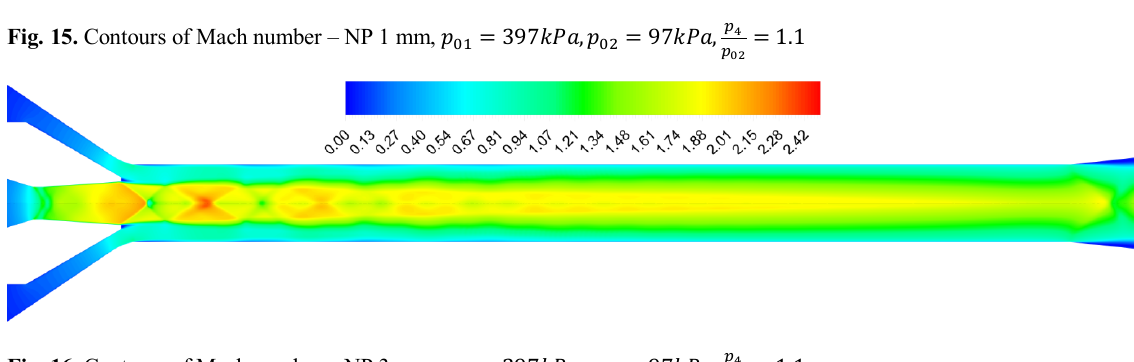
01 = 397𝑘𝑃𝑎,𝑝 02 = 97𝑘𝑃𝑎,